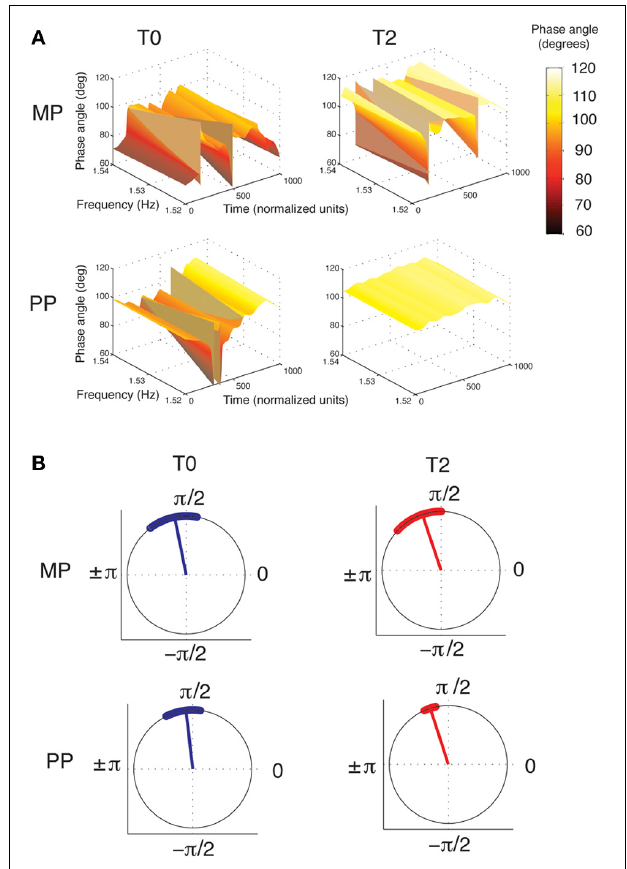
FIGURE 6 | Phase relationship between the wrist and fingers velocity profiles. (A) Grand-averages of the phase angles between the wrist and the fingers velocity profiles, for the MP and PP group (in each, n = 8). Phase angles are represented in the time-frequency space. Time was normalized to 1000 units (the corresponding duration of performance was ∼ 7.5s). The frequency axis is zoomed-in around the value of 1.53Hz, where the wrist-fingers coherence was found to be maximal (see Figure 5 ), and therefore the phase information more reliable. It can be seen that from T0 to T2, the overall phase angle increases. This represents a shift toward a stronger anti-phase pattern of coordination, in which peak velocity is achieved by one effector while the other is preparing the successive movement. MP and PP produces similar changes in the overall pattern, but PP results in greater stability of the phase angles across the time dimension. (B) Circular plot of phase angles between the wrist and finger velocity profiles. The dots along the circumference represent the distribution of phase angles during performance averaged across all subjects at each time point (for the purpose of this plot, the time has been normalized to 1000 points). The radius represents the circular mean of these angles. For both MP and PP, the phase angle increases from T0 to T2. However, only after PP does the distribution of phase angle become narrower, implying greater consistency of the phase angle during performance. Circular plots were created using the scripts provided by Berens (2009).